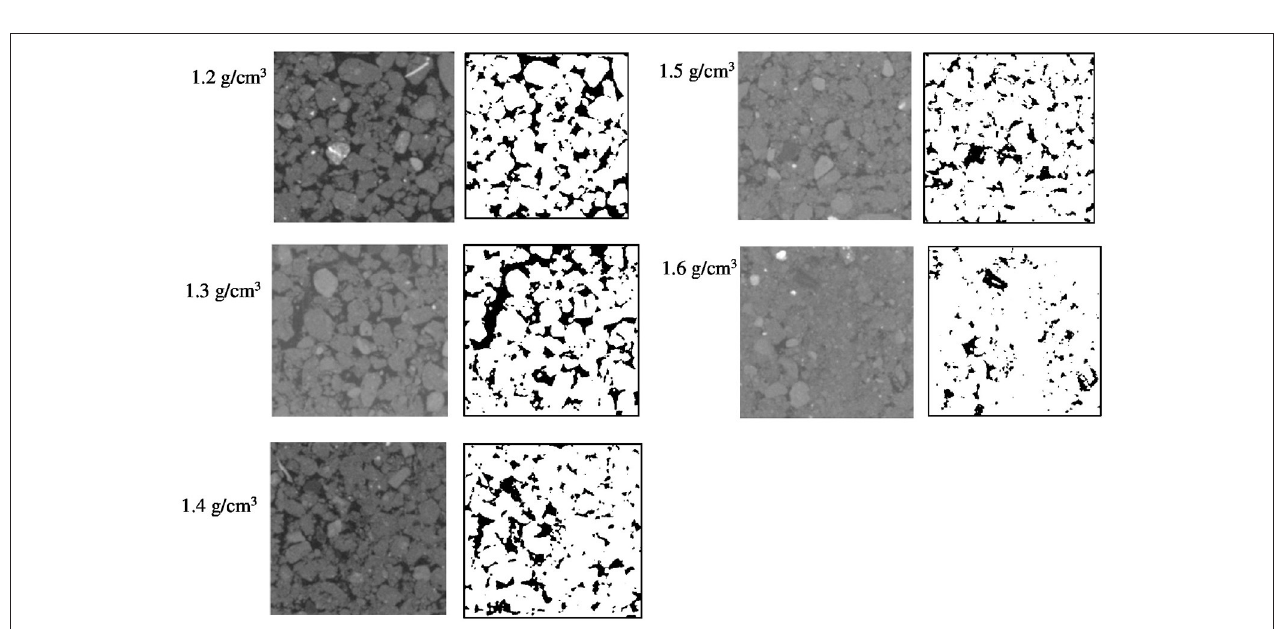
FIGURE 2 | Examples of segmented two-dimensional images of samples packed with 1–2mm sieved soil at BD ranging from 1.2 to 1.6g cm − 3 . The solid phase is represented by different gray-scales and through thresholding transformed into binary images with black representing the pores and white representing the solid